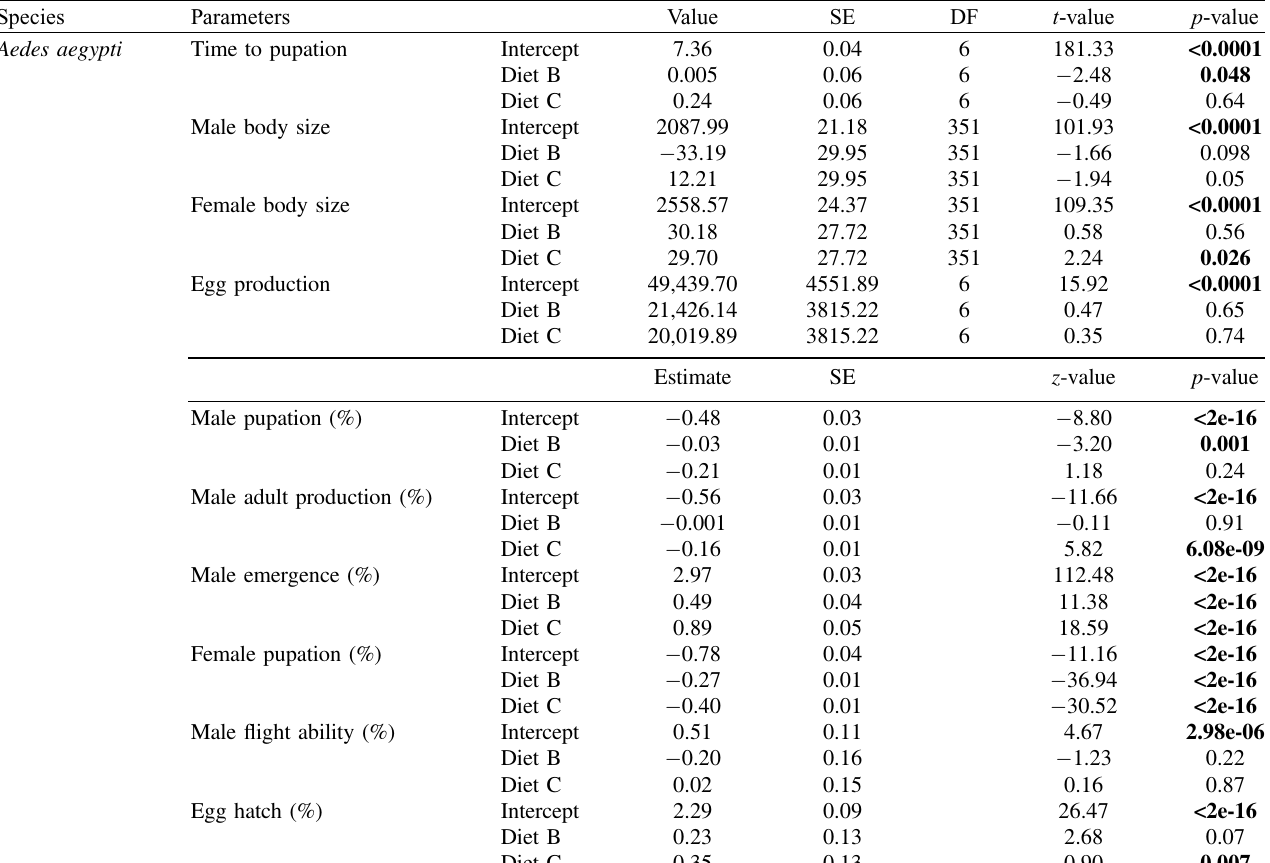
Table 4. Results of the linear mixed model and binomial generalized linear mixed model for the effect of diet mixtures on Aedes aegypti life history trait parameters. Values were compared to reference diet